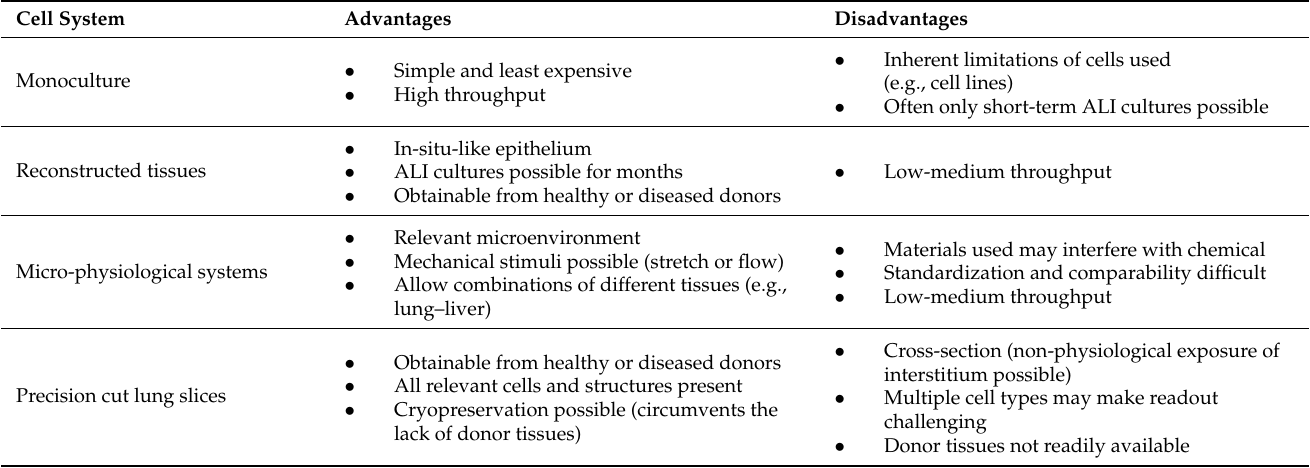
Table 2. Advantages and disadvantages of certain inhalation test systems. (Part of NAM-04 presenta- tion, Supplemental